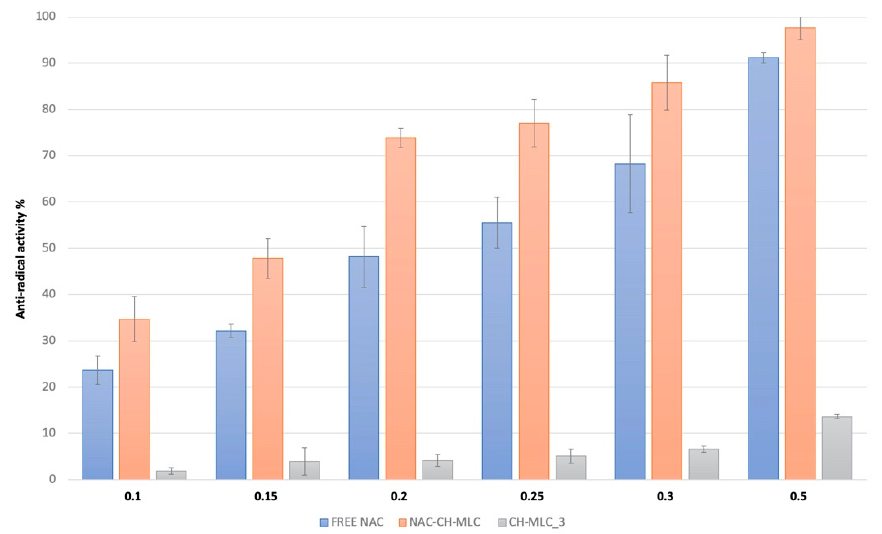
Figure 8. Antiradical activity percentages of free NAC, NAC-CH-MLC and CH-MLC_3 at active concentration range between 0.1 and 0.5 concentration range between 0.1 and 0.5 mg/mL.